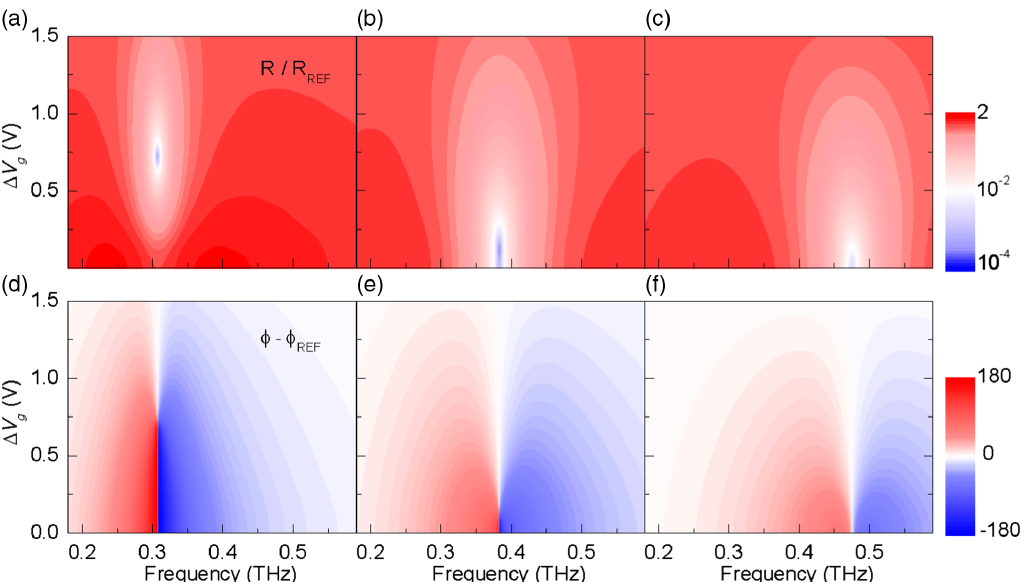
FIG. 7. FDTD simulations for the experiments described in Figs. 4. (a) – (c) Reflectance modulation as a function of both gate voltage and frequency for the devices with SU8 spacer thicknesses of 85, 60, and 40 μ m, respectively. Data from these three devices are normalized by the spectra calculated at Δ V values of 2.02, 2.03, and 1.73 V, respectively. (d) – (f) Reflection phase modulation as a g function of the gate voltage and frequency for the same devices in (a) – (c). The simulated devices have geometrical parameters identical to those of the devices shown in Fig.